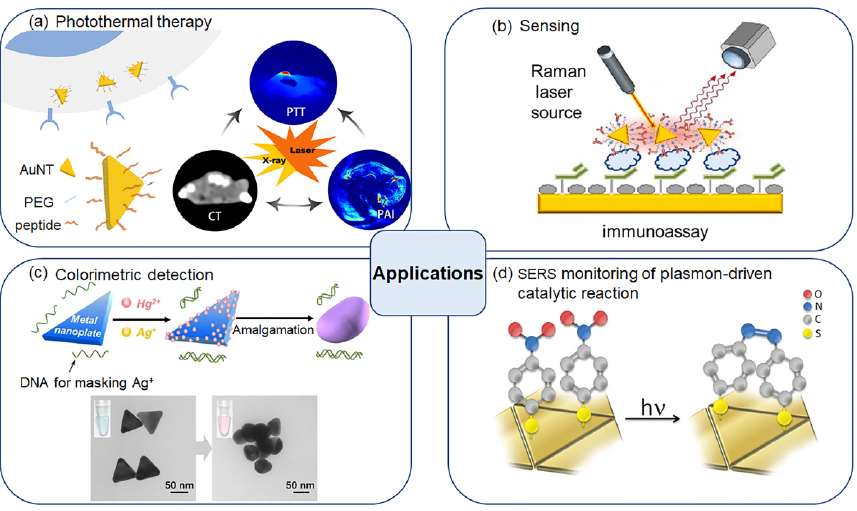
Figure 5. Applications of AuNTs and their assemblies. ( a ) Anti ‐ EGFR peptide ‐ conjugated AuNTs for computed tomography/photoacoustic imaging ‐ guided photothermal therapy of non ‐ small ‐ cell lung cancer. Adapted with permission from Ref. [48]. Copyright © 2022 American Chemical Society; ( b ) AuNT assemblies for early detection of gestational diabetes mellitus. Adapted with permission from Ref. [49]. Copyright © 2022 Elsevier B.V.; ( c ) Colorimetric determination of mercury (II) ion based on DNA ‐ assisted AuNTs. Adapted with permission from Ref. [92]. Copyright © 2022 Springer ‐ Verlag GmbH Austria; ( d ) AuNTs for SERS monitoring of plasmon ‐ driven catalytic reac ‐ tions. Adapted with permission from Ref. [50]. Copyright © 2022 American Chemical Society.